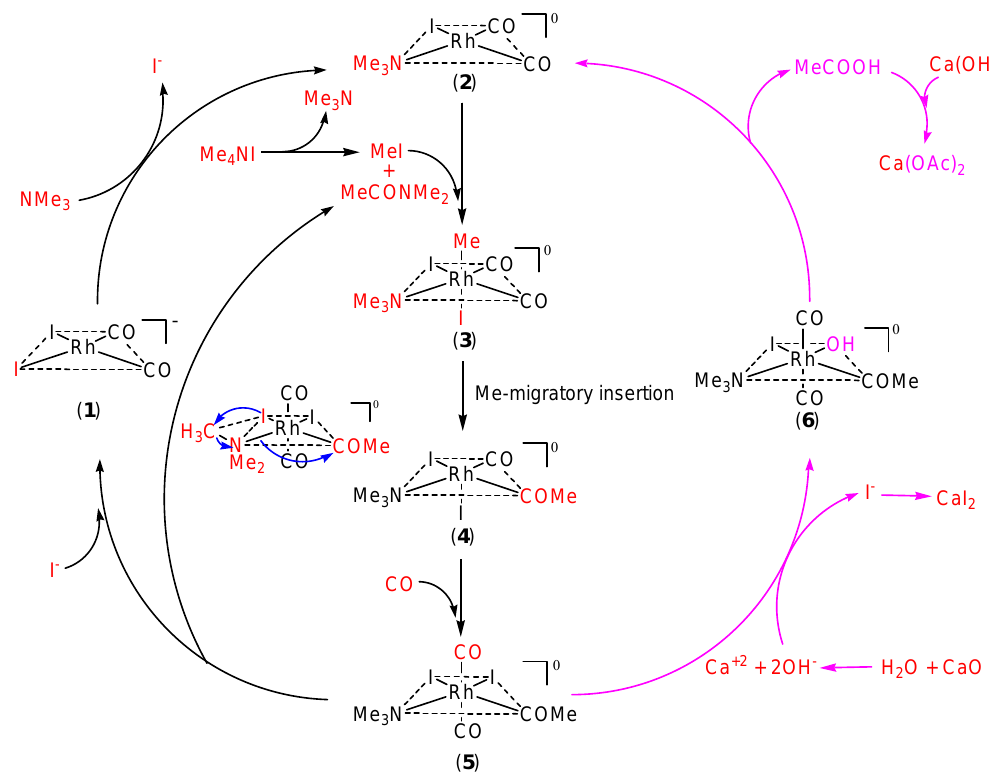
Figure 1. Mechanism of rhodium-catalyzed carbonylation of